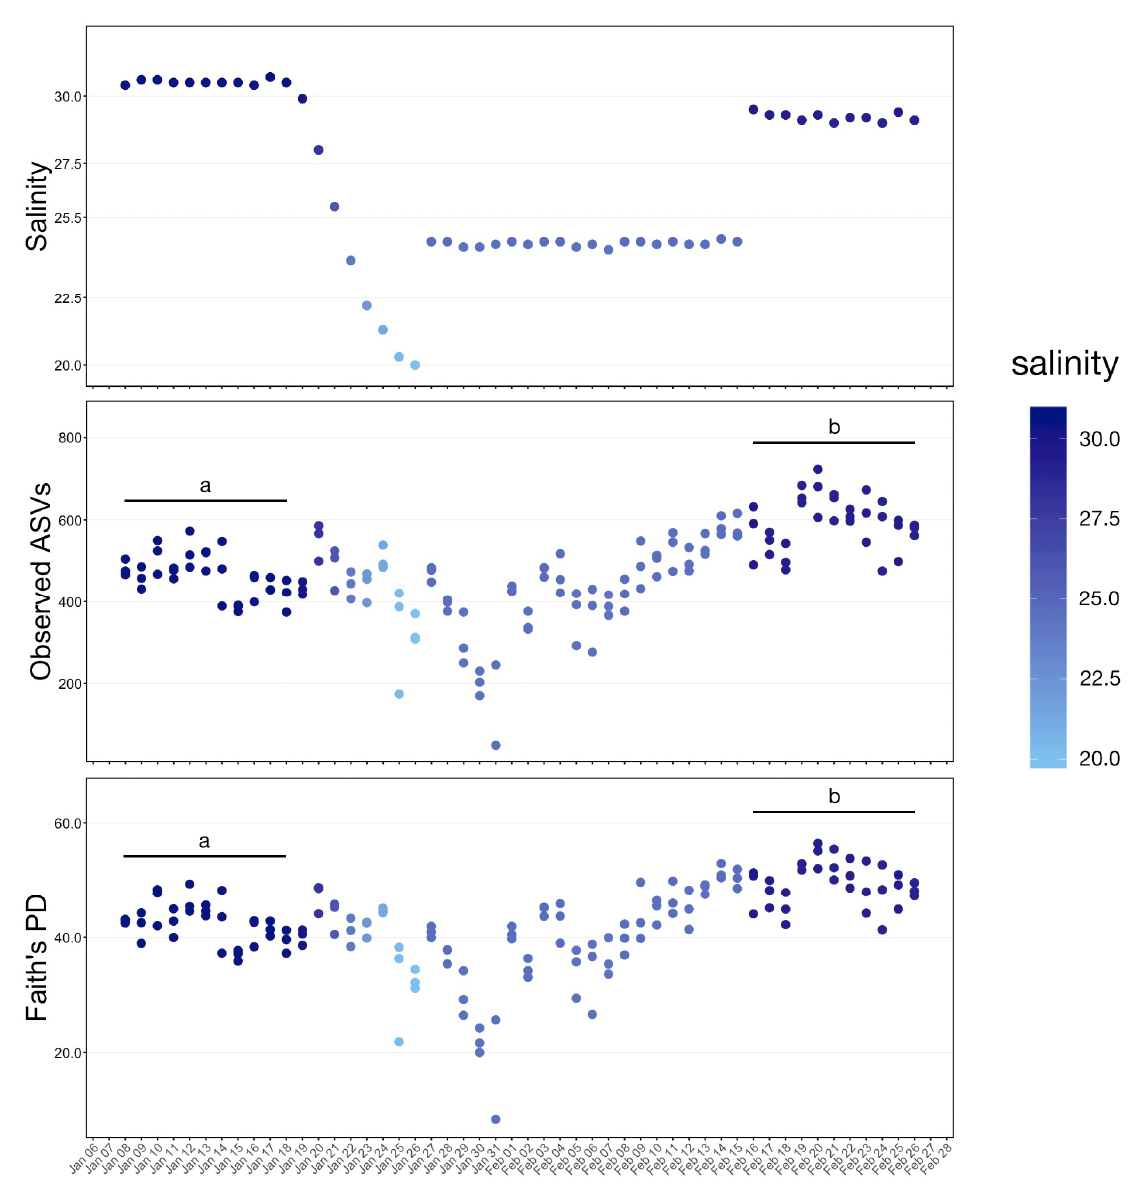
Figure 3. Scatterplot tracking changes on salinity ( top ), richness (Observed ASVs— middle ), and diversity (Faith’s PD— bottom ) in water communities as the water change progressed from 8 January to 26 February. Points are colored based on salinity values. Significant differences in mean diversity values between pre- (8–18 January; n = 33) and post- (16–26 February; n = 33) water change are illustrated by different letters (Kruskal–Wallis, p < 0.05).